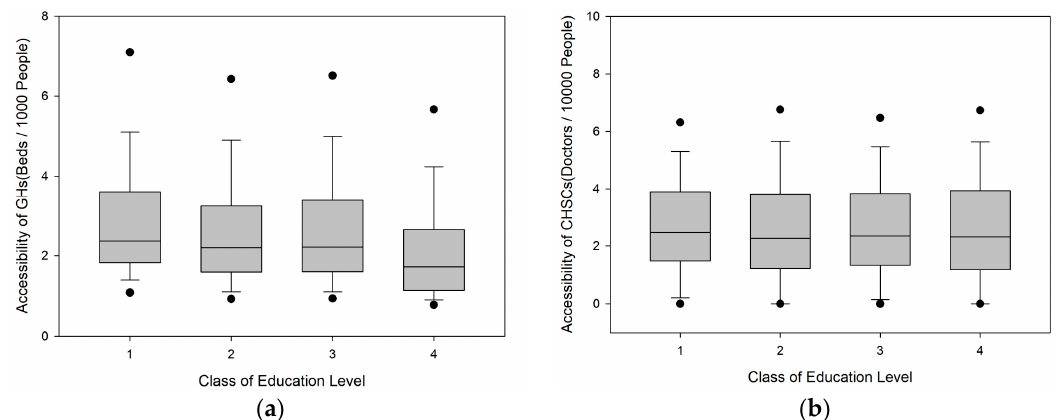
Figure 6. Box-plots of the accessibility for different classes of education level. ( a ) Box-plots of the accessibility of GHs; ( b ) Box-plots of the accessibility of CHSCs.